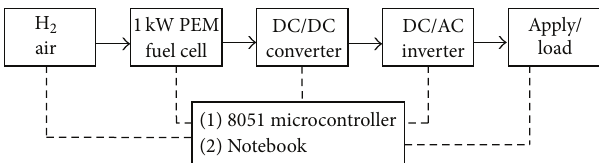
Figure 3: Block diagram of intelligent control system for PEMFC